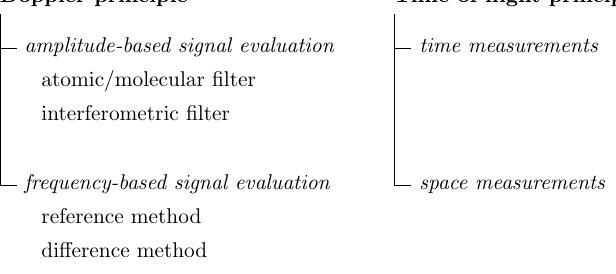
Figure 4. Categorization of flow velocity measurement approaches based on Mie scattering.